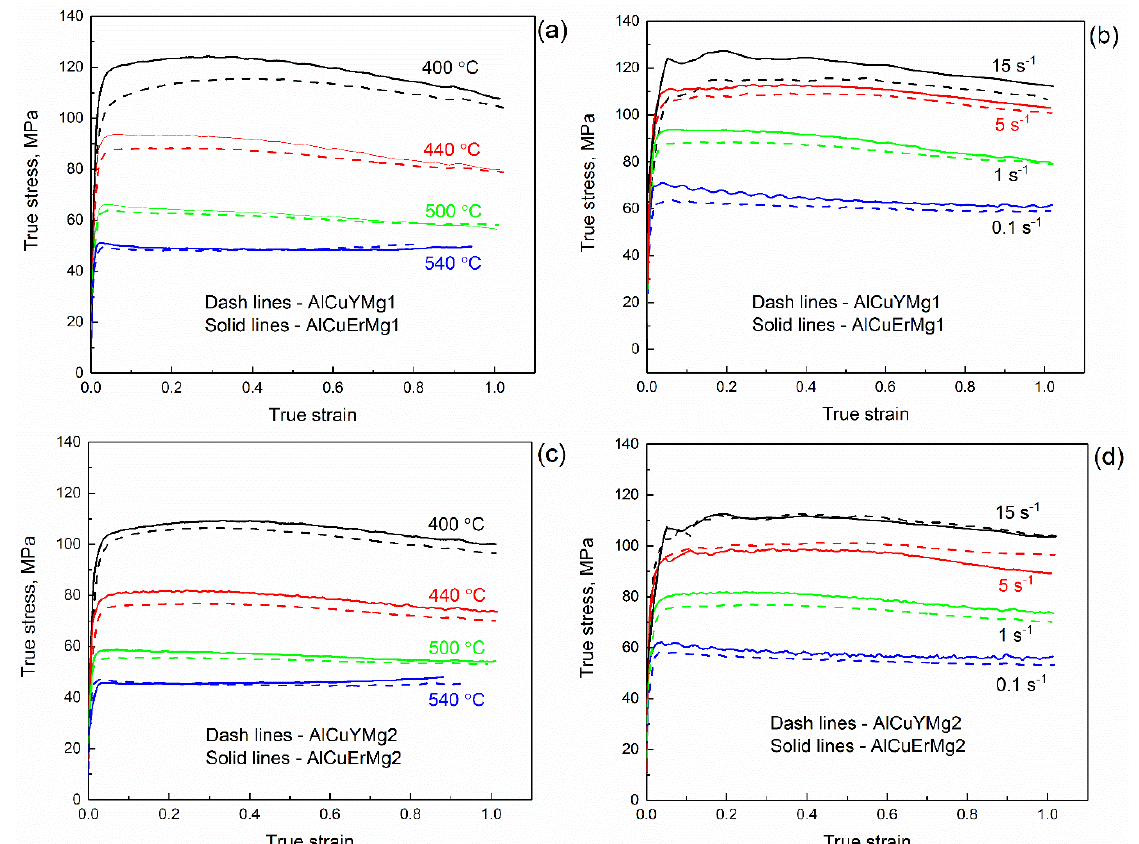
Figure 2. Typical true stress–true strain curves for the investigated alloys deformed at a strain rate of 1 s − 1 ( a , c ) and at a temperature of 440 °C ( b , d ).